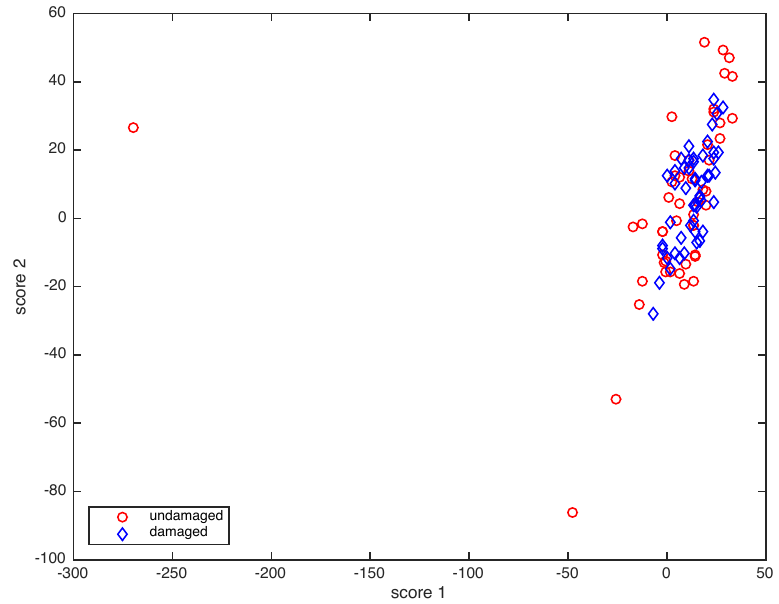
Figure 4. Projection onto the two first principal components of samples coming from the healthy wind turbine (red, circle) and from the faulty wind turbine (blue,